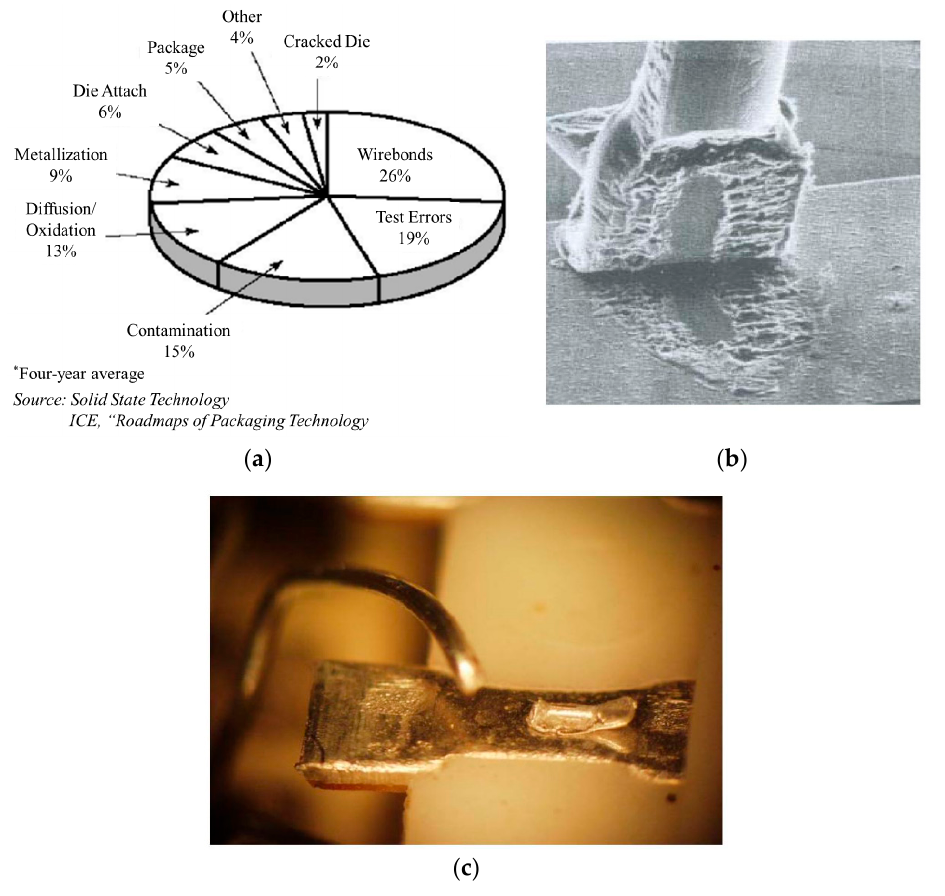
Figure 6. ( a ) A pie-chart depicting the failure modes in SiC power modules; ( b ) a photograph showing wire bond lift off; and ( c ) a photograph showing wire bond heel fracture [37]. Reprint with permission [4062731448789]; Copyright 2008, IEEE.